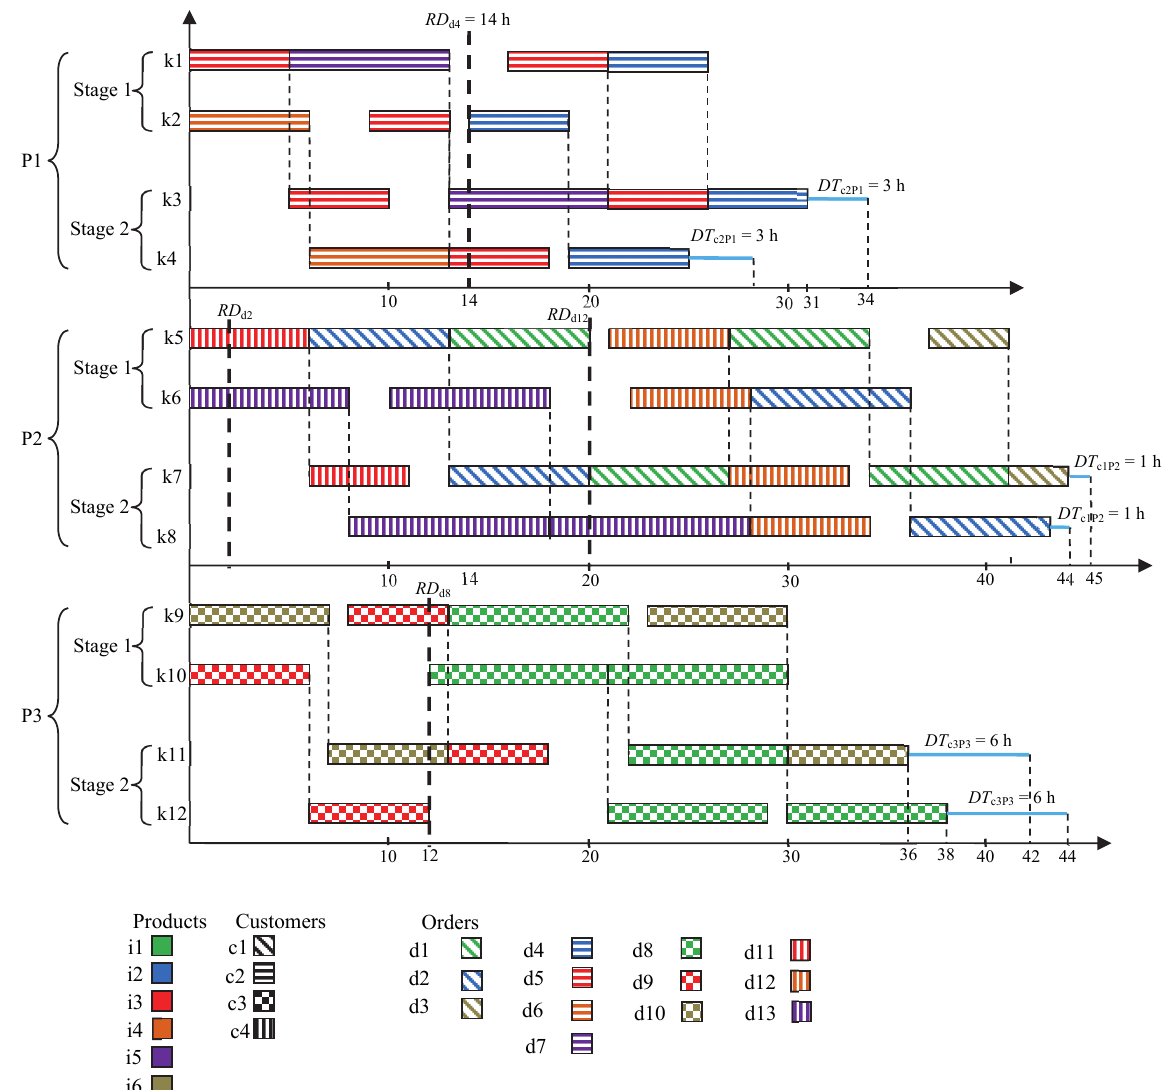
Fig. 6. Gantt chart for cooperation policy of Example